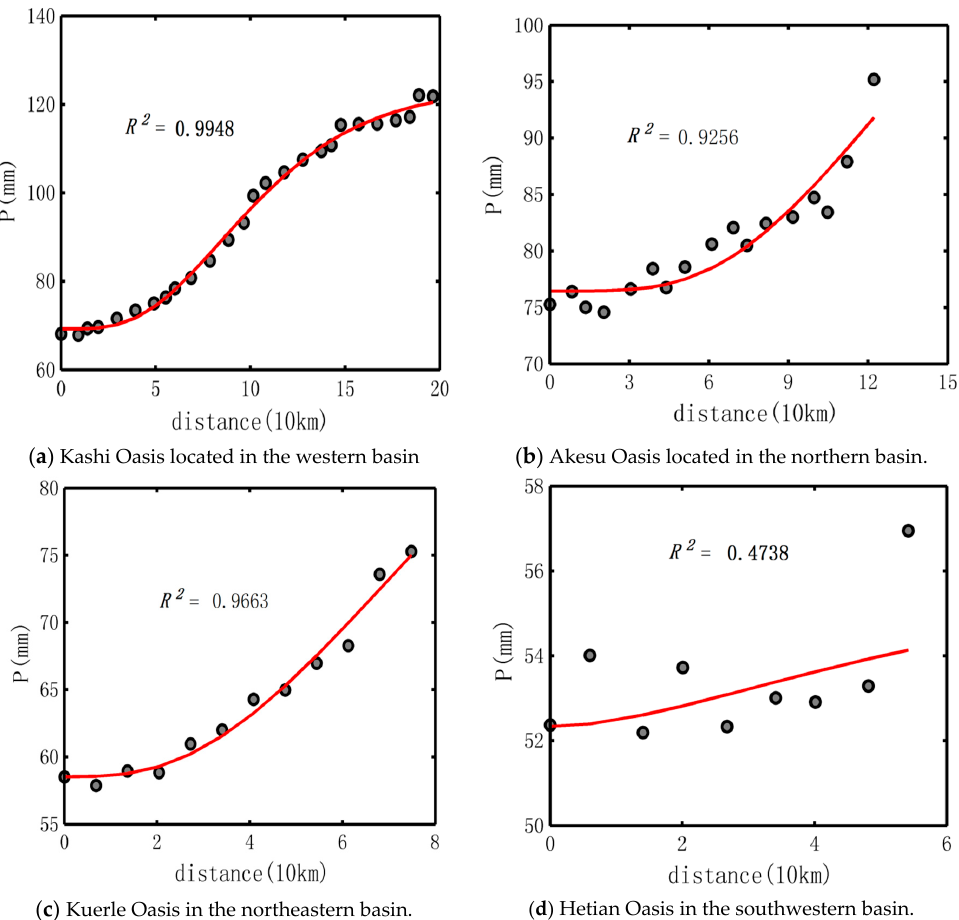
Figure 5. Performance of the model simulating precipitation from desert to oasis in different areas of Tarim Basin. Tarim